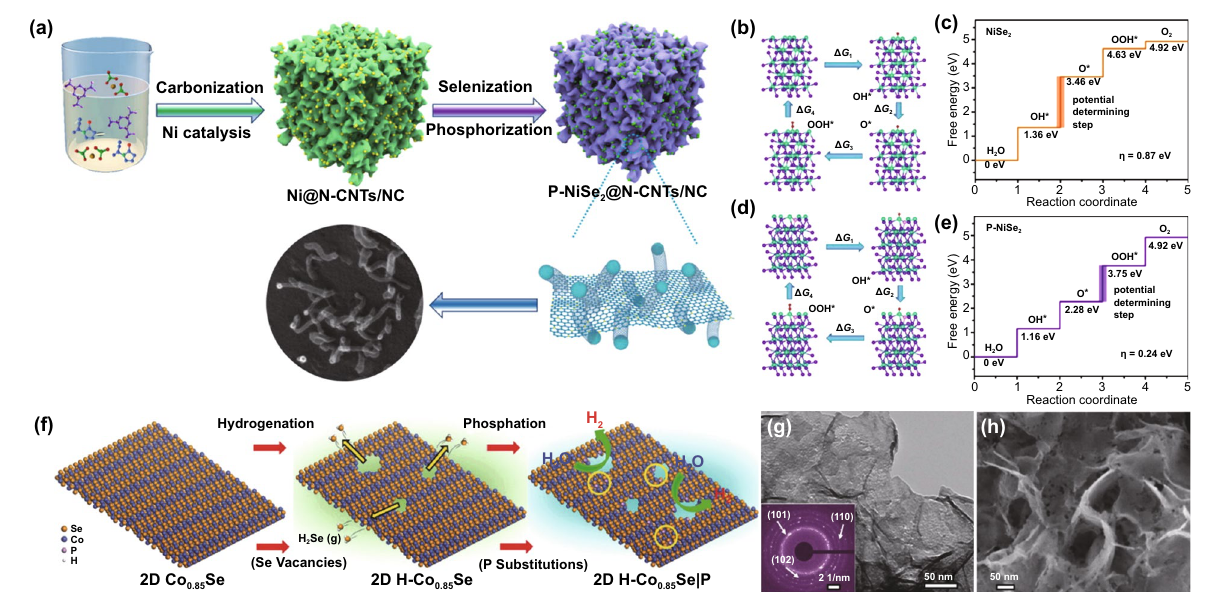
Fig. 13 a Schematic illustration for the preparation procedure of P–NiSe 2 @N–CNTs/NC, b Schematic illustration for the four elementary steps during oxygen generation process on NiSe 2 , c Calculated free-energy diagram for the OER paths on NiSe 2 at zero potential, d Schematic illus- tration for the four elementary steps during oxygen generation process on P–NiSe 2 in 1 M KOH, e Calculated free-energy diagram for the OER paths on and P–NiSe 2 at zero potential. Ni, Se, P, O, and H atoms are represented by green, purple, pink, red and white spheres, respectively. Reprinted with permission from Ref. [73]. Copyright Year 2021, Elsevier. f Schematic illustration for the synthesis process of H–Co 0.85 Se|P, g TEM image of H–Co 0.85 Se|P, h FESEM image of H–Co 0.85 Se|P. Reprinted with permission from Ref. [176] Copyright Year 2017, Wiley–VCH Verlag GmbH & Co. KGaA,